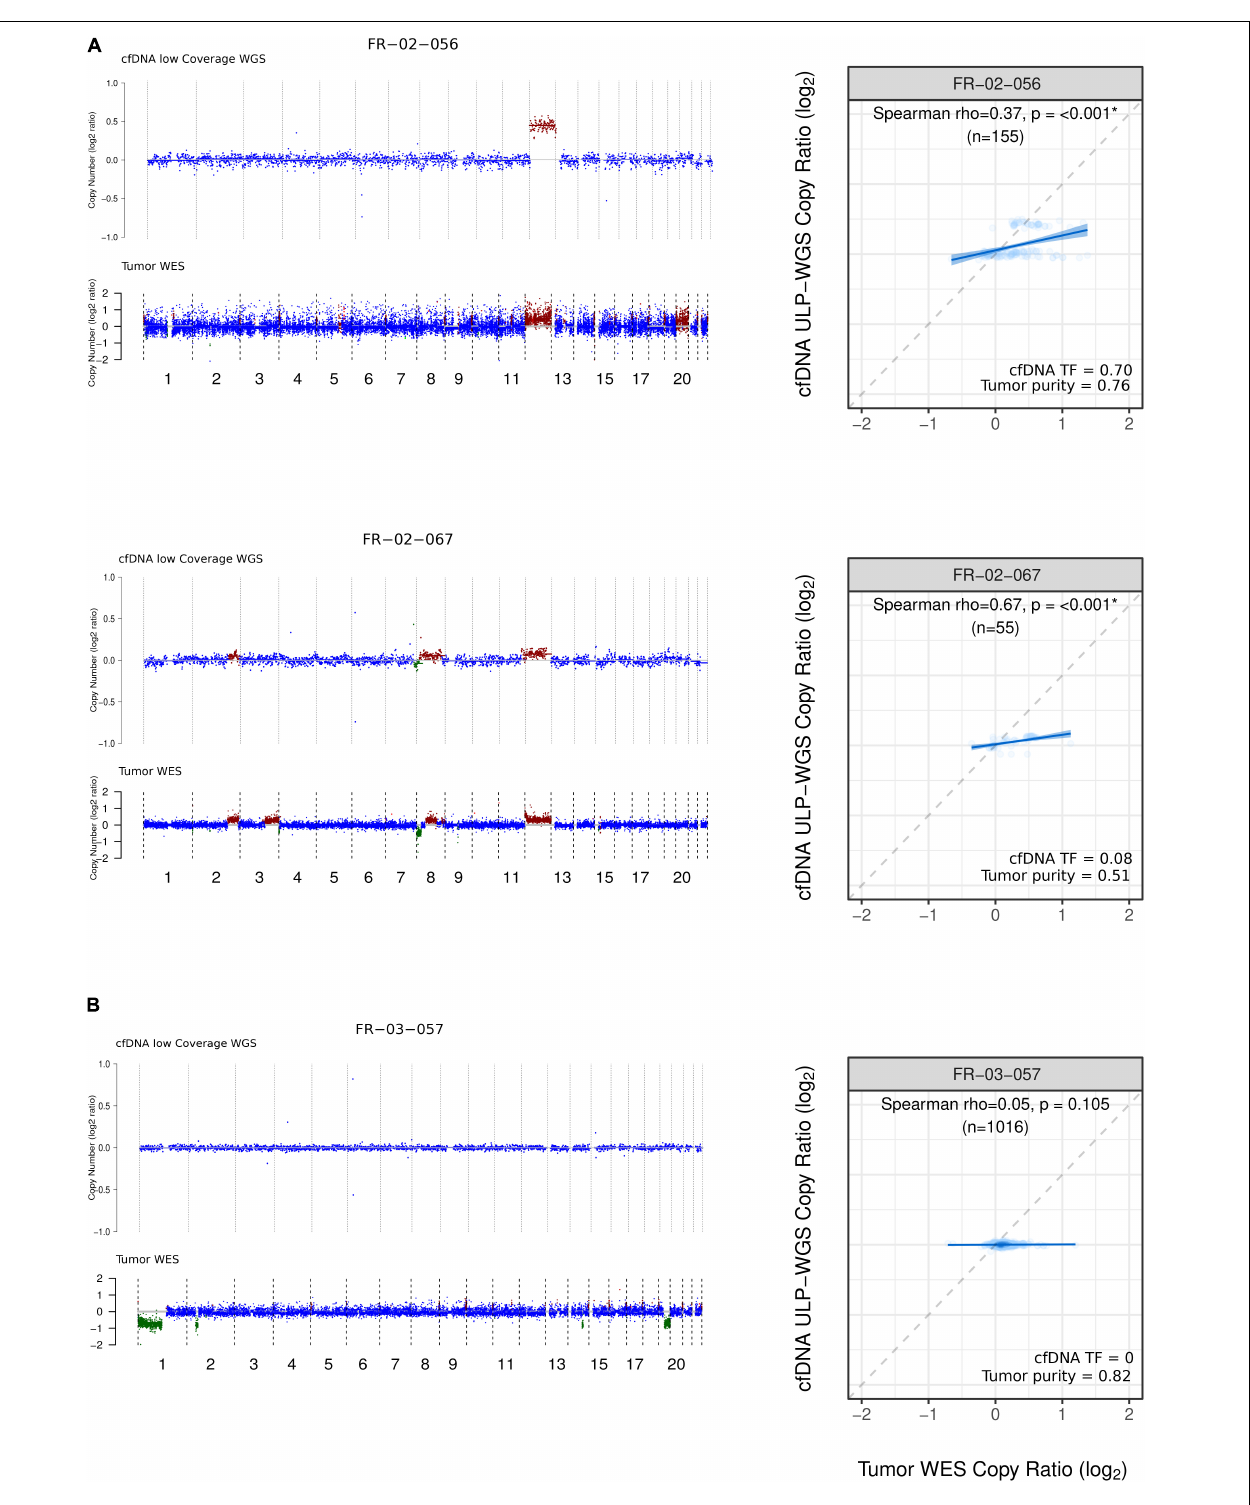
FIGURE 2 | Copy number profile and comparison from LC-WGS cfDNA and WES tumor biopsy. (A) Left track shows genome-wide copy number from two ID-NHL patients (FR-02-056 and FR-02-067 with the following median coverage for cfDNA 4.24X, 3.49X and for WES tumor biopsy 216X, 211X, respectively). Right track shows cfDNA tumor fraction (TF) computed using ichorCNA and Tumor purity calculated using ABSOLUTE. (B) Left track shows genome-wide copy number from a 1p19q codeleted glioma patient FR-03-057 with the following median coverage for 4.30X for cfDNA and 166 X for WES tumor biopsy. Right track shows Spearman rank correlation between LC-WGS cfDNA and WES tumor biopsy (see Materials and Methods ).